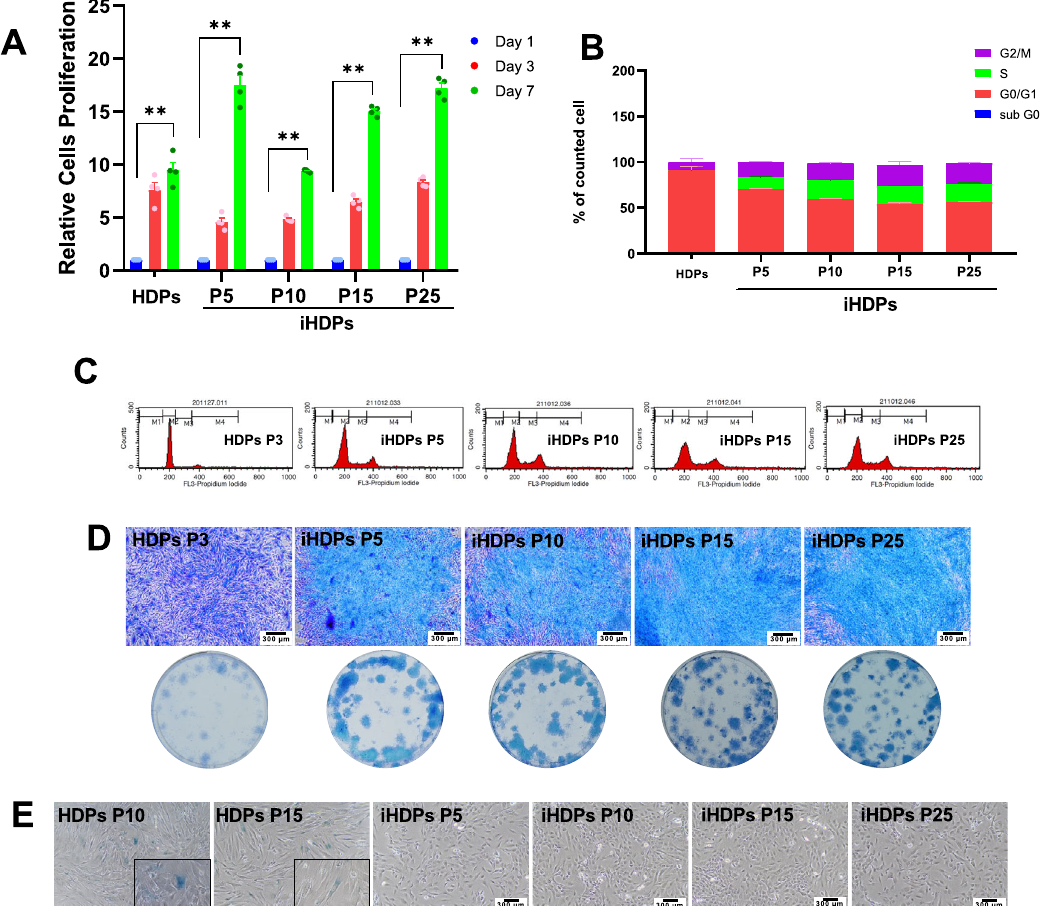
Fig. 2 Cell proliferation of ihDPs. Cell proliferation was evaluated using an MTT assay on days 1, 3, and 7 ( A ). Cell cycle analysis was performed using fl ow cytometry ( B , C ). Colony-forming unit assay. Scale bars: 300 µm ( D ). Senescence-associated β -galactosidase activity. Scale bars: 300 µm ( E ). The inset images showed the β -galactosidase-positive cells. Bars indicate a signi fi cant difference between groups (* P < 0.05, ** P <